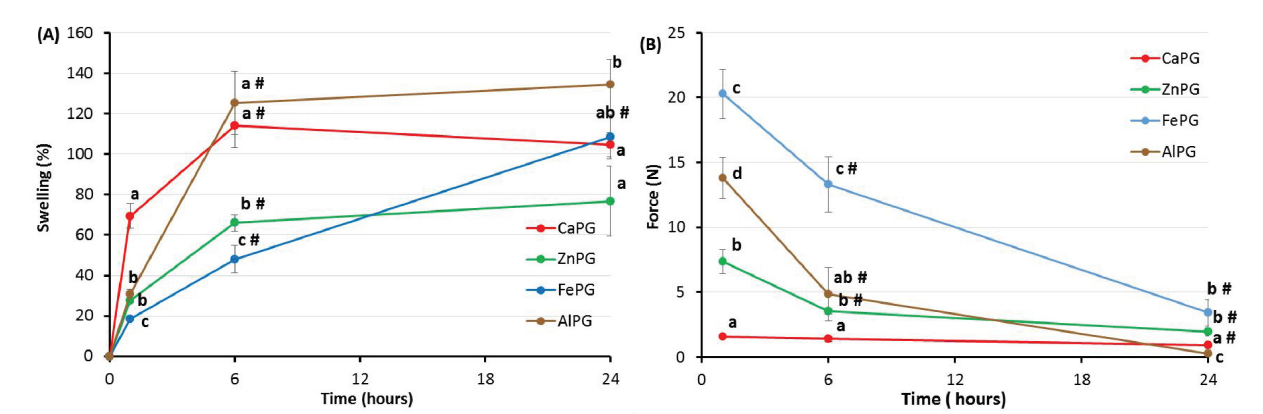
Figure 3. Swelling degree ( A ) and gel strength ( B ) of CaPG, ZnPG, FePG, and AlPG beads incubated for 24 h in RPMI-1640 medium supplemented with 10% FBS. The data are presented as the mean ( n = 5). Different letters indicate significant differences between pectin gel beads prepared with different cations ( p < 0.05). # p < 0.05 vs. previous time